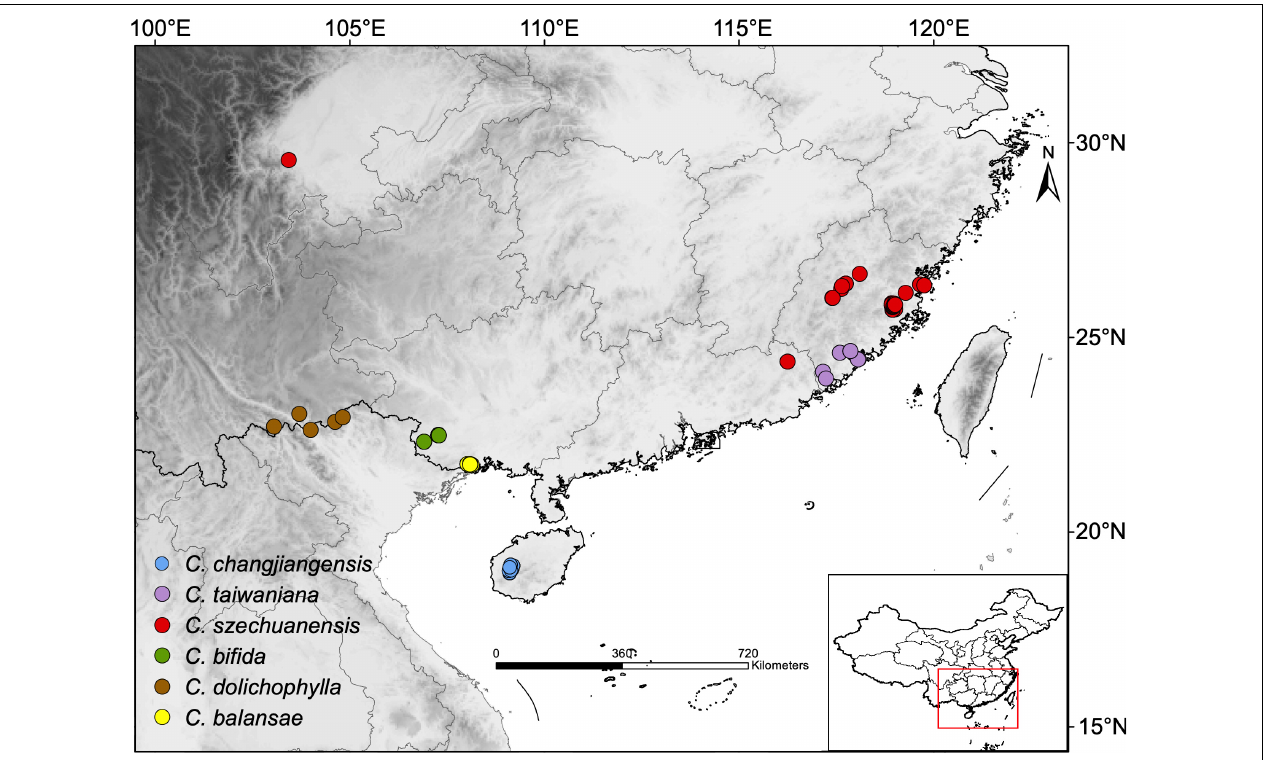
FIGURE 1 | Map of sampling sites (inset map shows the sampling location on a map of China) for the six species of Cycas analyzed in the present study. Each dot represents a sampled individual and individuals are colored by